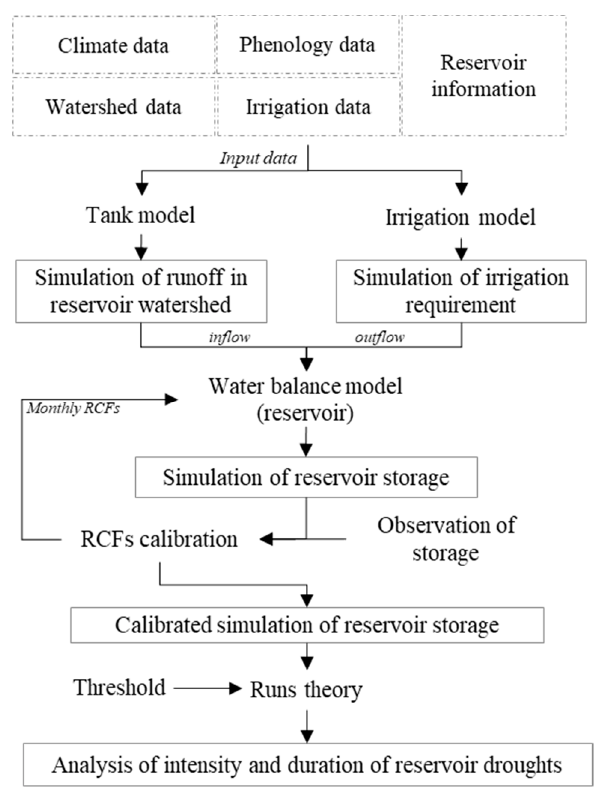
Figure 1. A flowchart of adapting RCF (ratio correction factor) calibration and assessing climate change impacts on reservoir droughts .